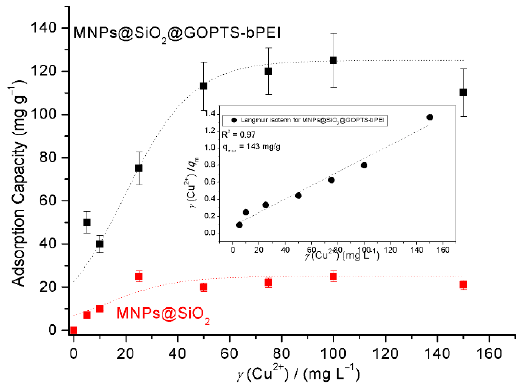
Figure 9. Effect of the initial Cu 2+ concentration on the adsorption capacity for unmodified and GOPTS-bPEI modified MNPs@SiO 2